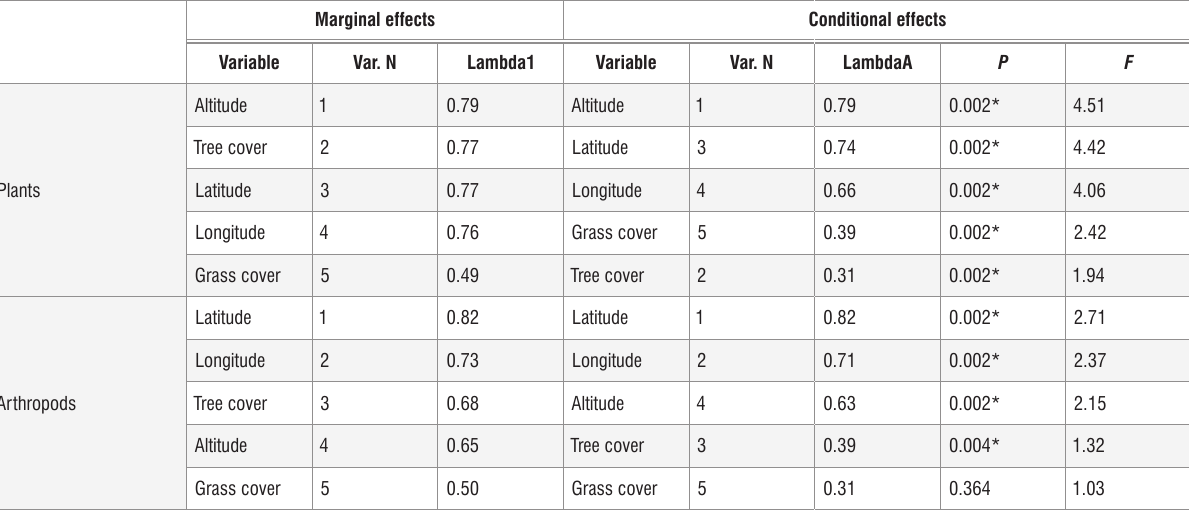
Table 6: Marginal and conditional effects of automatic forward selection conducted for all plants and all arthropods Marginal effects Conditional